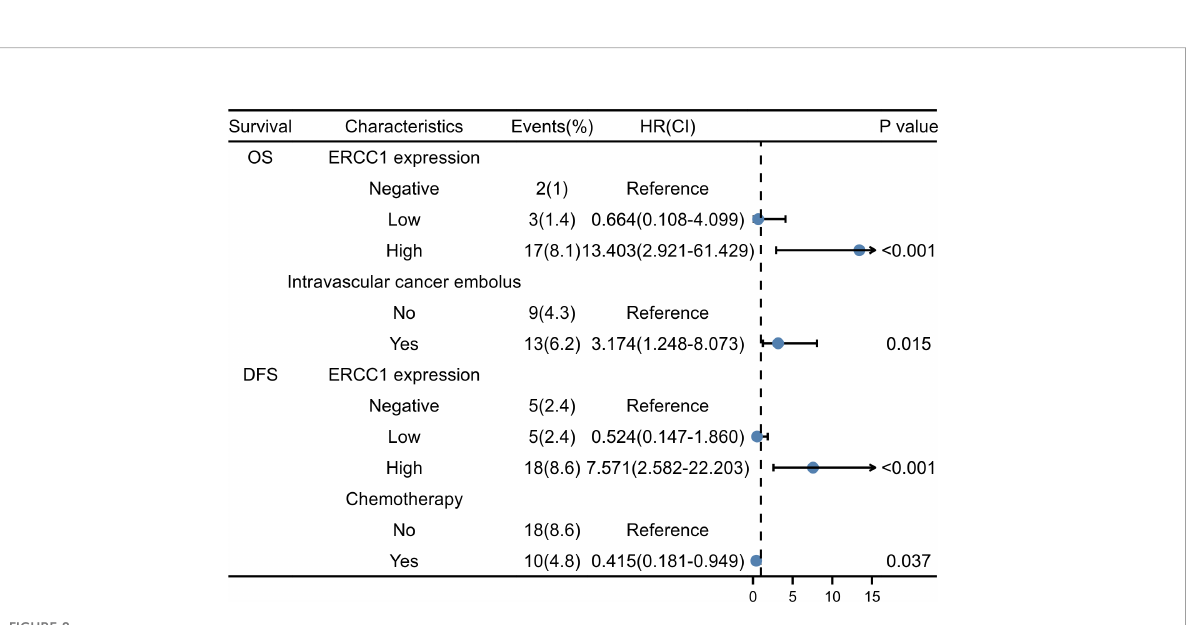
FIGURE 8 The forest plot of multivariate COX survival